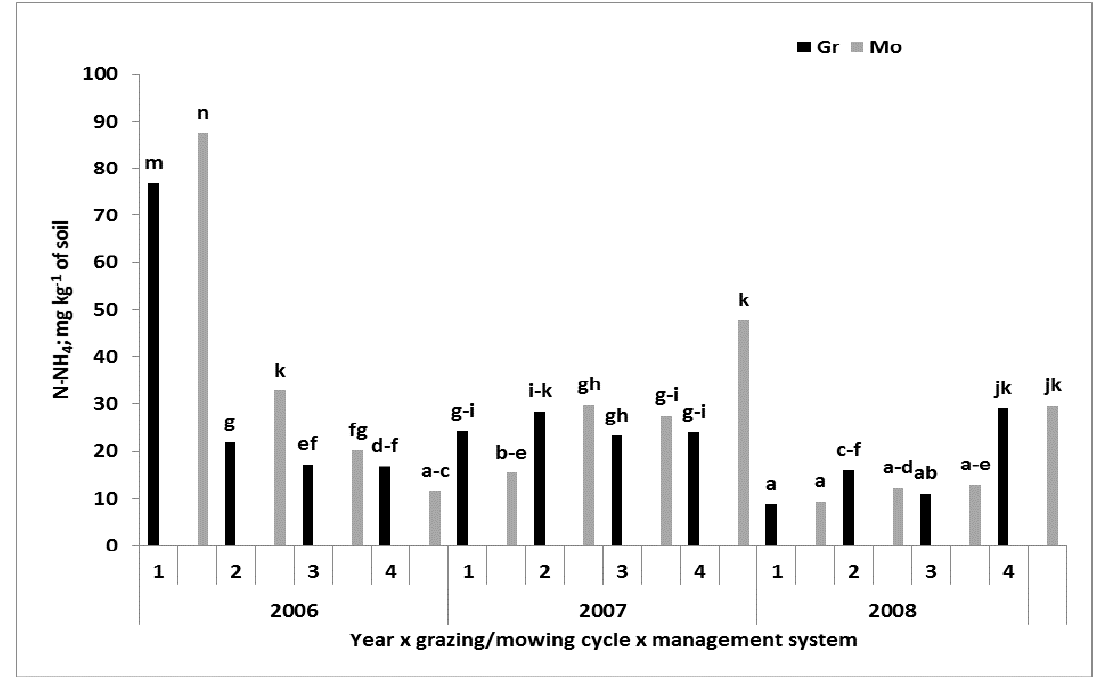
Figure 5. Effect of the grassland management in consecutive cut on ammonium content. a The same letter indicates a lack of significant differences within the treatment ( p < 0.05).